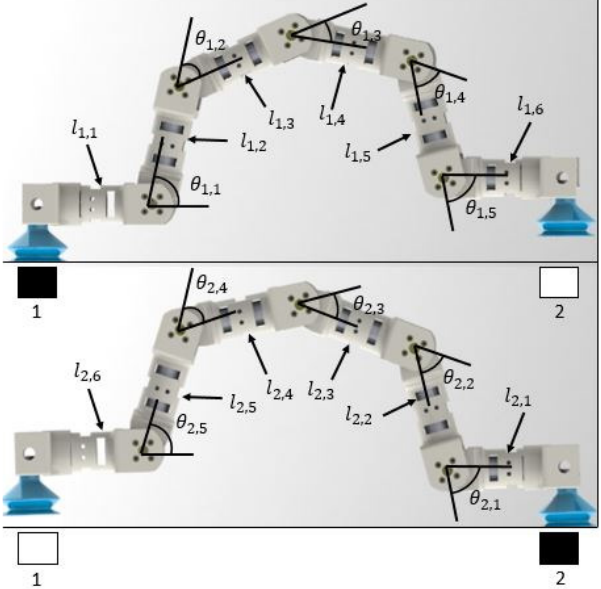
Figure 1. Distribution of the WBRD’s degrees of freedom dependent on the activated vacuum